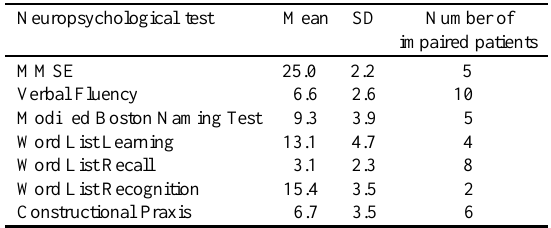
Table 2 Number of correct responses for the FTLD patients and the controls (means and standard deviations, SD) on the facial expressions with 100% emotional intensity (maximum score per emotion = 4) FTLD patients Controls